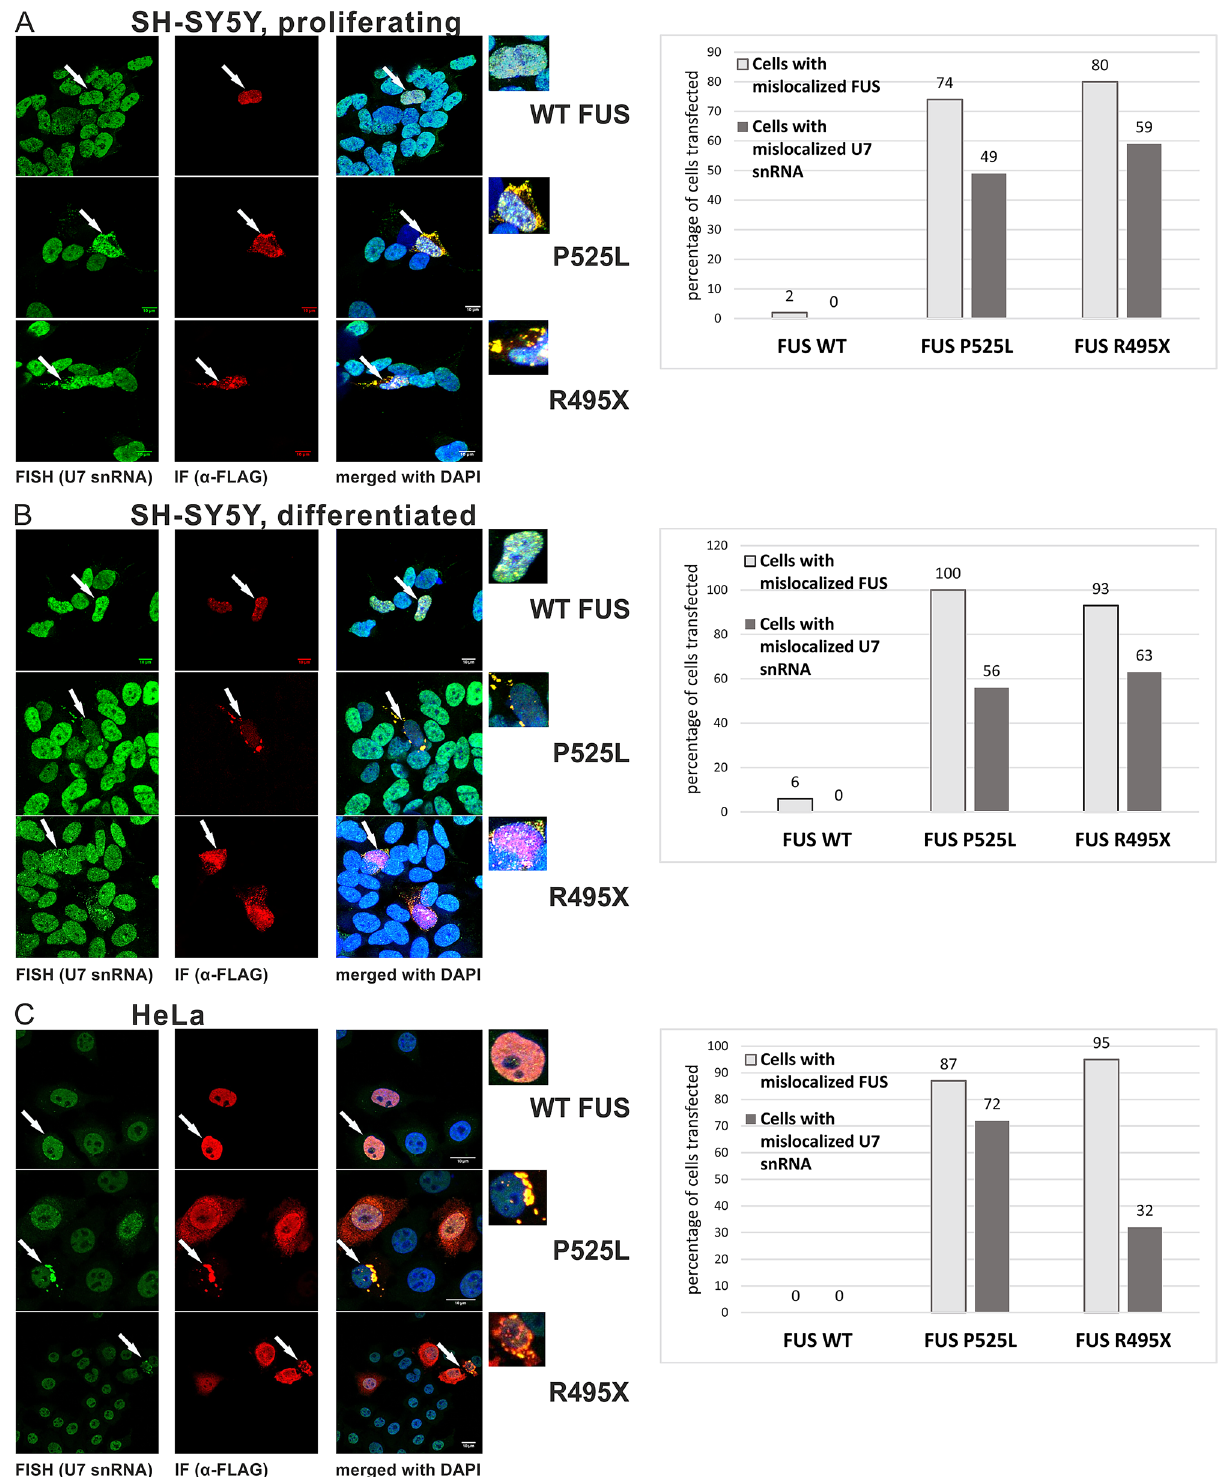
Figure 1. Localization of FUS and U7 snRNA in cells transfected with plasmids carrying FUS WT and ALS-linked FUS mutations. Fluorescent in-situ hybridization (FISH) using a probe against U7 snRNA in combination with immunofluorescence (IF) using anti-FLAG antibodies was performed in SH-SY5Y FUS KO ( A , B ) and HeLa FUS KO ( C ) cells transfected with FLAG-tagged FUS. DAPI was used for nuclear staining. Graphs show the percentage of transfected cells with mislocalization of FUS and U7 snRNA. WT FUS—cells transfected with plasmids encoding the wild-type FUS gene. P525L and R495X—cells transfected with plasmids encoding the FUS gene with P525L and R495X